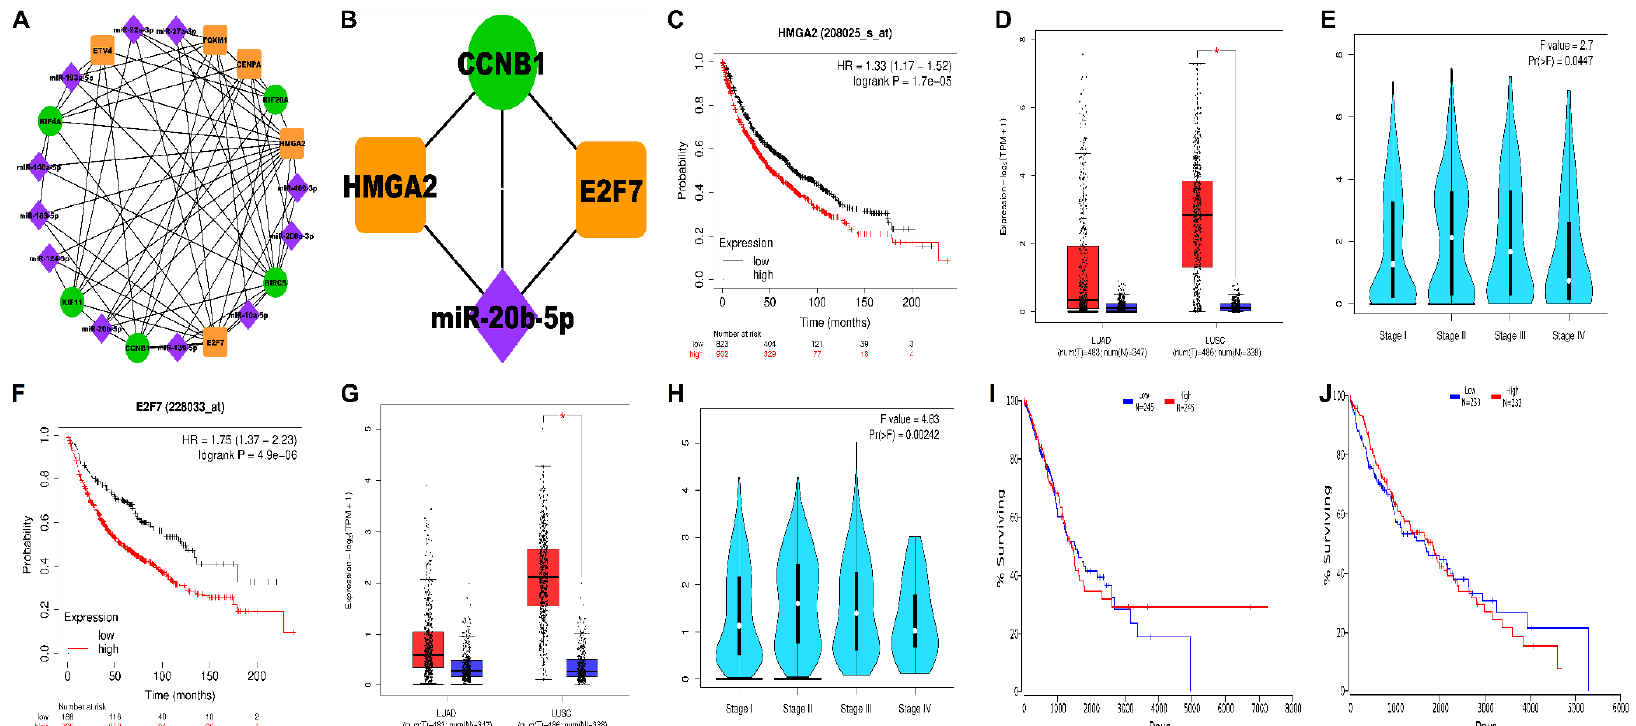
Figure 5. [A] NSCLC-specific 3-node miRNA FFL regulatory network comprising 21 nodes and 66 edges, respectively. [B] The highest-order network motif consisting of one miRNA (miR-20b-5p), two TFs (HMGA2 and E2F7), and one hub gene (CCNB1), respectively. The green circular nodes represent the hub genes / mRNAs, magenta diamond nodes represent miRNAs, and orange rectangular nodes represent the TFs, respectively. KM survival curves of [C] HMGA2 represents a shorter OS in NSCLC patients with its increased expression levels. Boxplot comparing the relative expression levels of [D] HMGA2 in LUAD and LUSC patients with respect to normal samples. Violin stage plot of [E] HMGA2 showing the association of its expression levels and various tumor stages in NSCLC patient samples. KM survival curves of [F] E2F7 represents a shorter OS in NSCLC patients with its increased expression levels. Boxplot comparing the relative expression levels of [G] E2F7 in LUAD and LUSC patients with respect to normal samples. Violin stage plot of [H] E2F7 showing the association of its expression levels and various tumor stages in NSCLC patient samples. KM survival curves of miR-20b-5p plotted using OncoLnc in [I] LUAD and [J] LUSC patient samples. Lower expression levels of miR-20b-5p tend to worsen the OS in both LUAD and LUSC